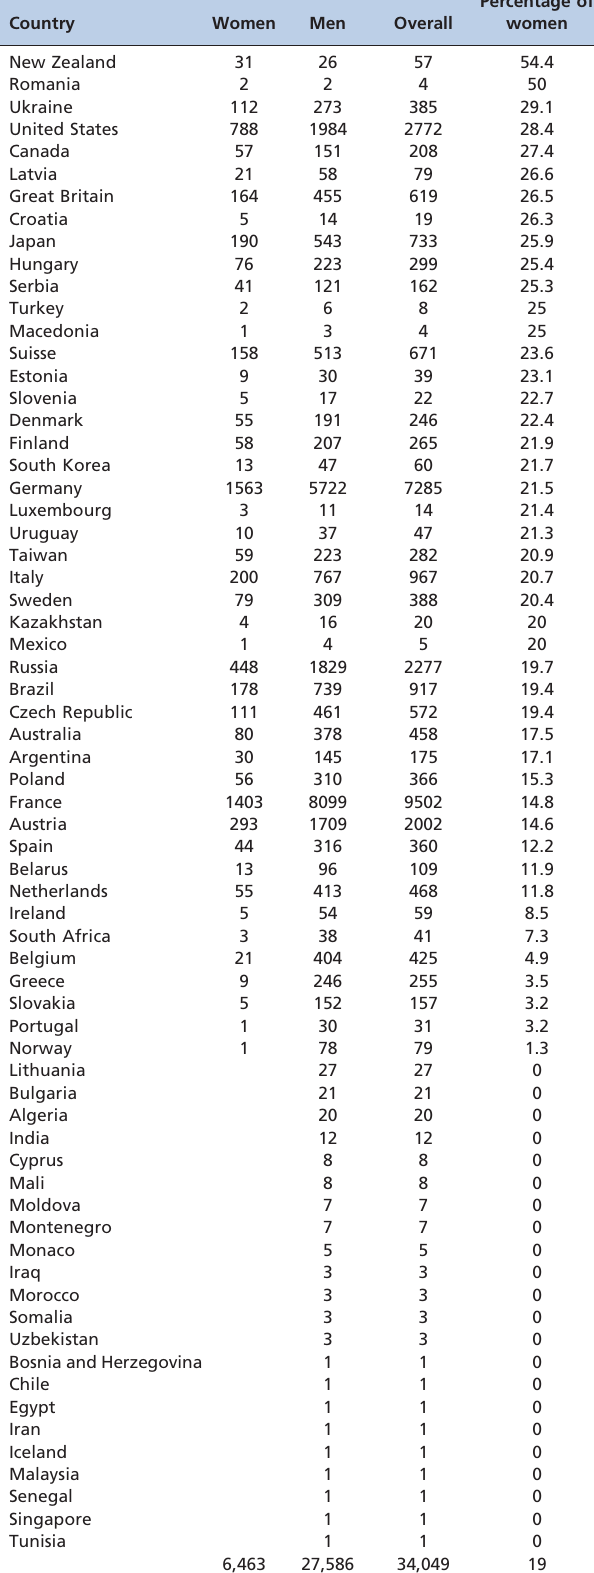
Table 1 - Number of total finishers for each country, sorted by the percentage of female